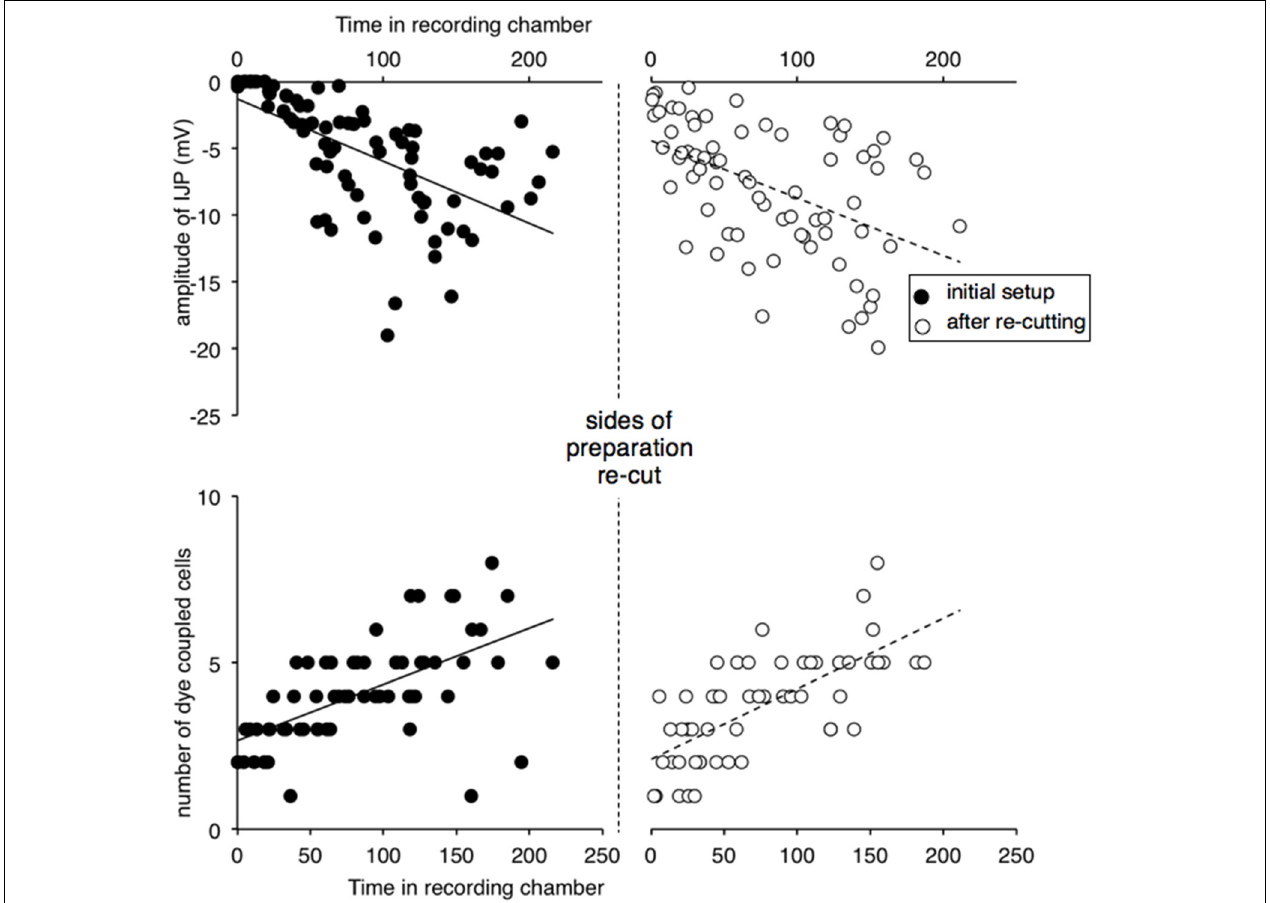
FIGURE 3 | Replication of effects of re-cutting the edges of preparation. Recordings were carried out by an independent researcher. Preparations ( n = 4) were recorded after initial set-up and after re-cutting the edges either side of the preparation. Inhibitory junction potentials were initially immeasurable, when preparations were first recorded and increased in